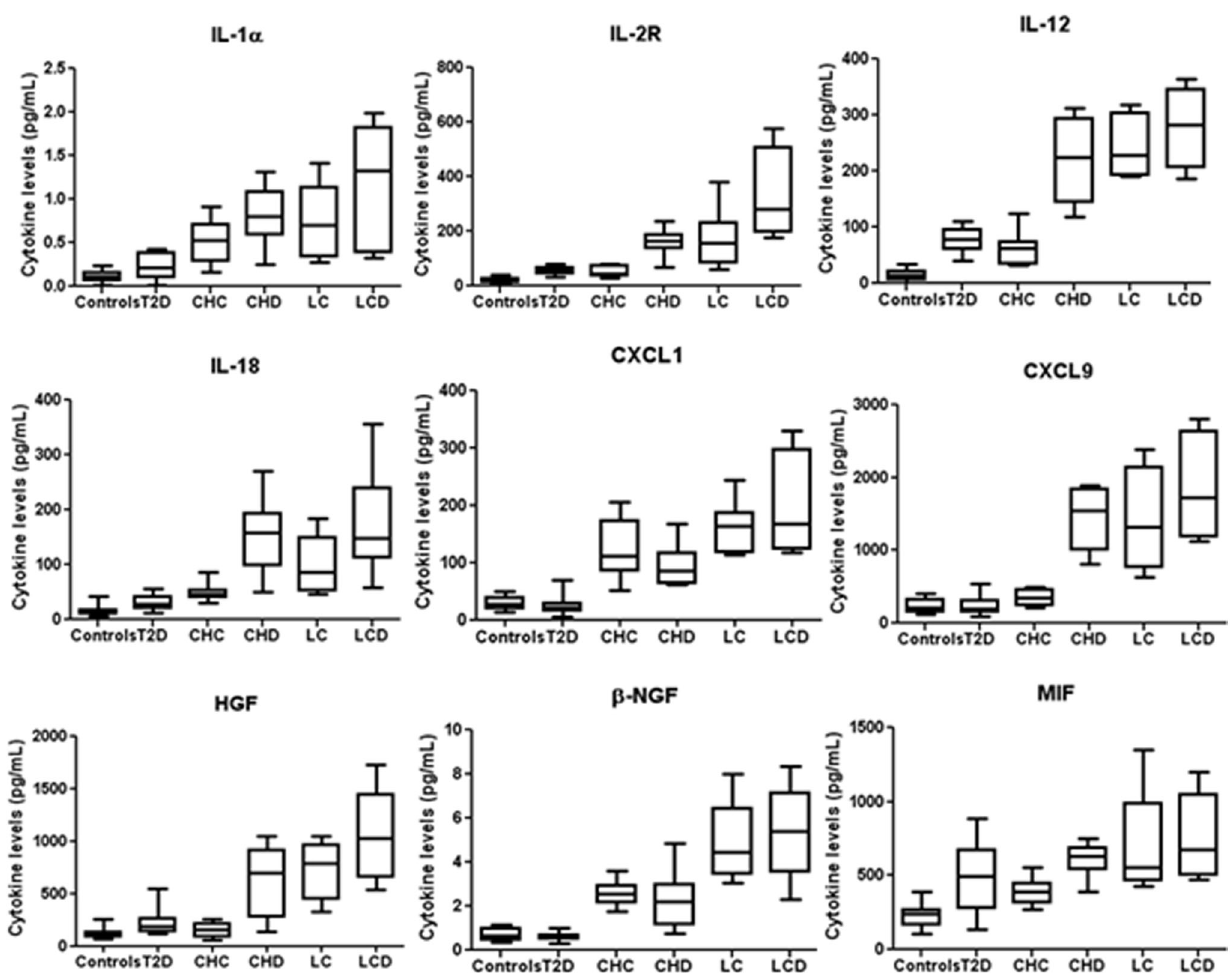
Figure 1. Significant cytokines in some patient groups. We report the significant molecule levels from controls and patients with type 2 diabetes (T2D), chronic hepatitis C (CHC), CHC-related cirrhosis (LC), CHC hepatitis and type 2 diabetes (CHD) and CHC-related cirrhosis and type 2 diabetes (LCD), evaluated by 21-Plex panel, are plotted with box-and-whisker graphs. The boxes extend from the 25th to the 75th percentile, and the line in the middle is the median. The error bars extend down to the lowest value and up to the